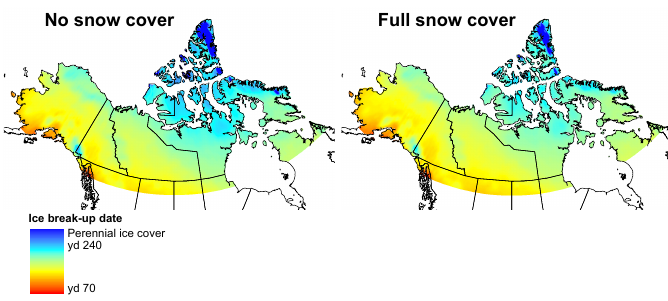
Fig. 4. Mean simulated break-up dates for 1961–1990 for hypothetical 10m lakes, for both no snow and full snow scenarios. lake rather than the snow cover scenario (Fig. 5). Freeze-up